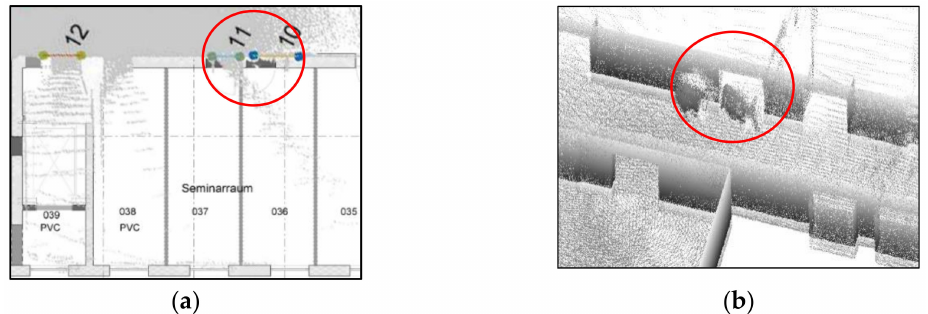
Figure 21. Mis-detected door in the ground plane ( a ) xy-plane ( b ) and 3D point clouds (detail in Figure 17b).